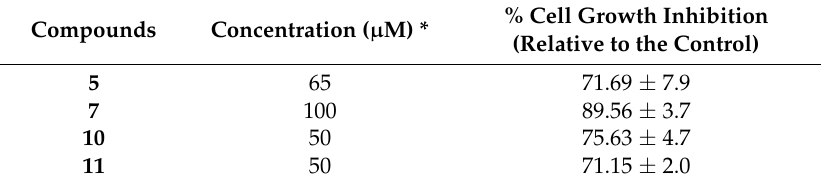
Table 2. The percentage of cell growth inhibition (relative to the control) of 5 , 7 , 10 , and 11 in the non-malignant MCF-12A human breast epithelial cells.